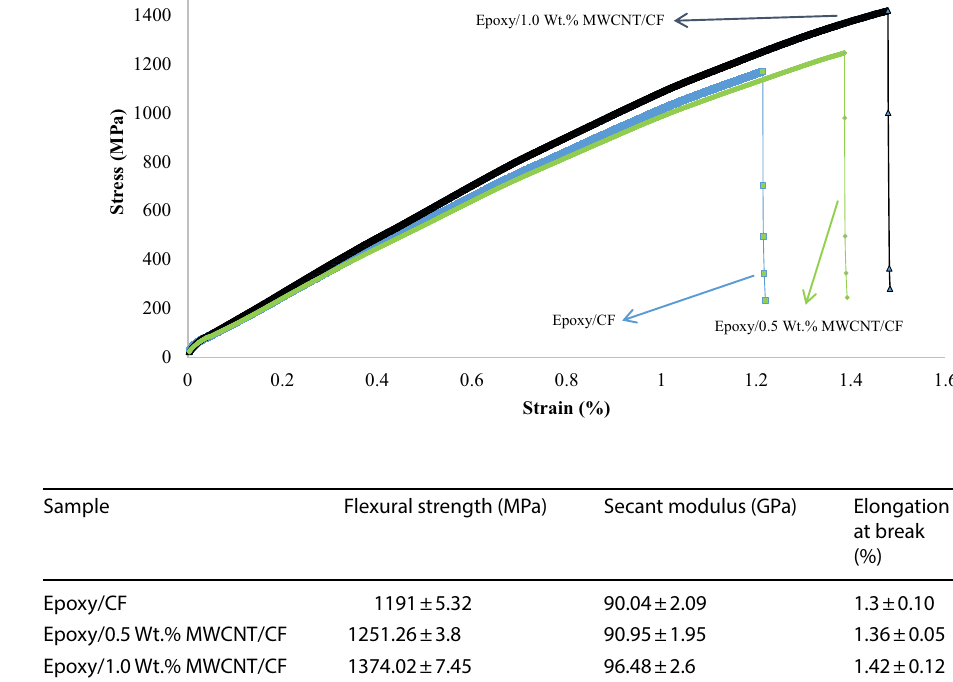
Fig. 8 Flexural stress–strain curves of nanocomposites